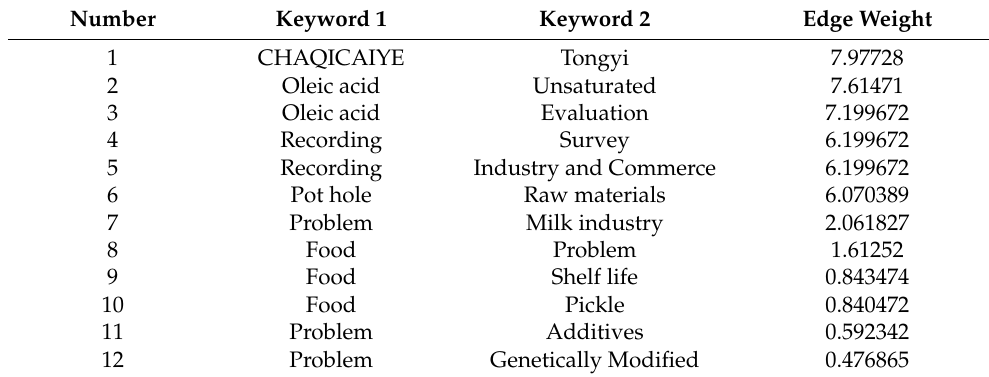
Table 10. Edge weights of co-occurring words.